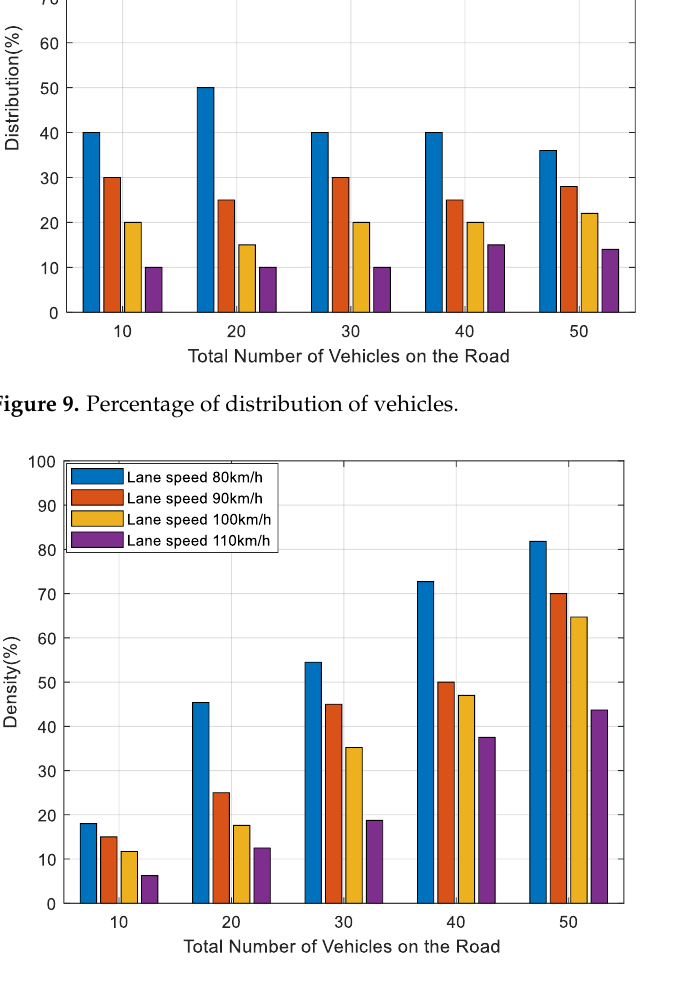
Table 1. Simulation parameters.